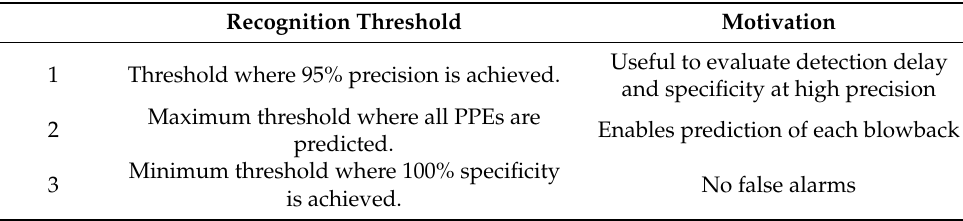
Table 8. Recognition thresholds selected for model evaluation.